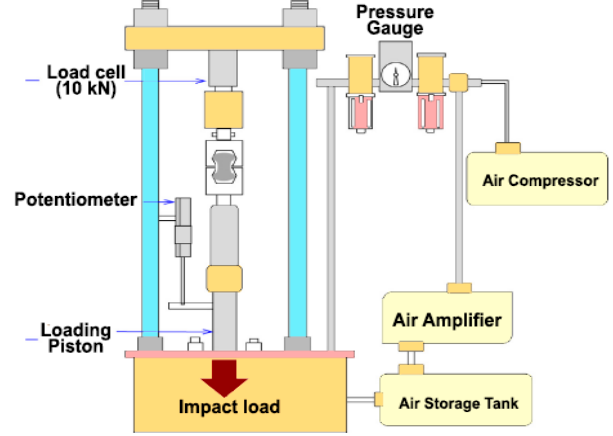
Figure 6. Pull-out test experiment setup .